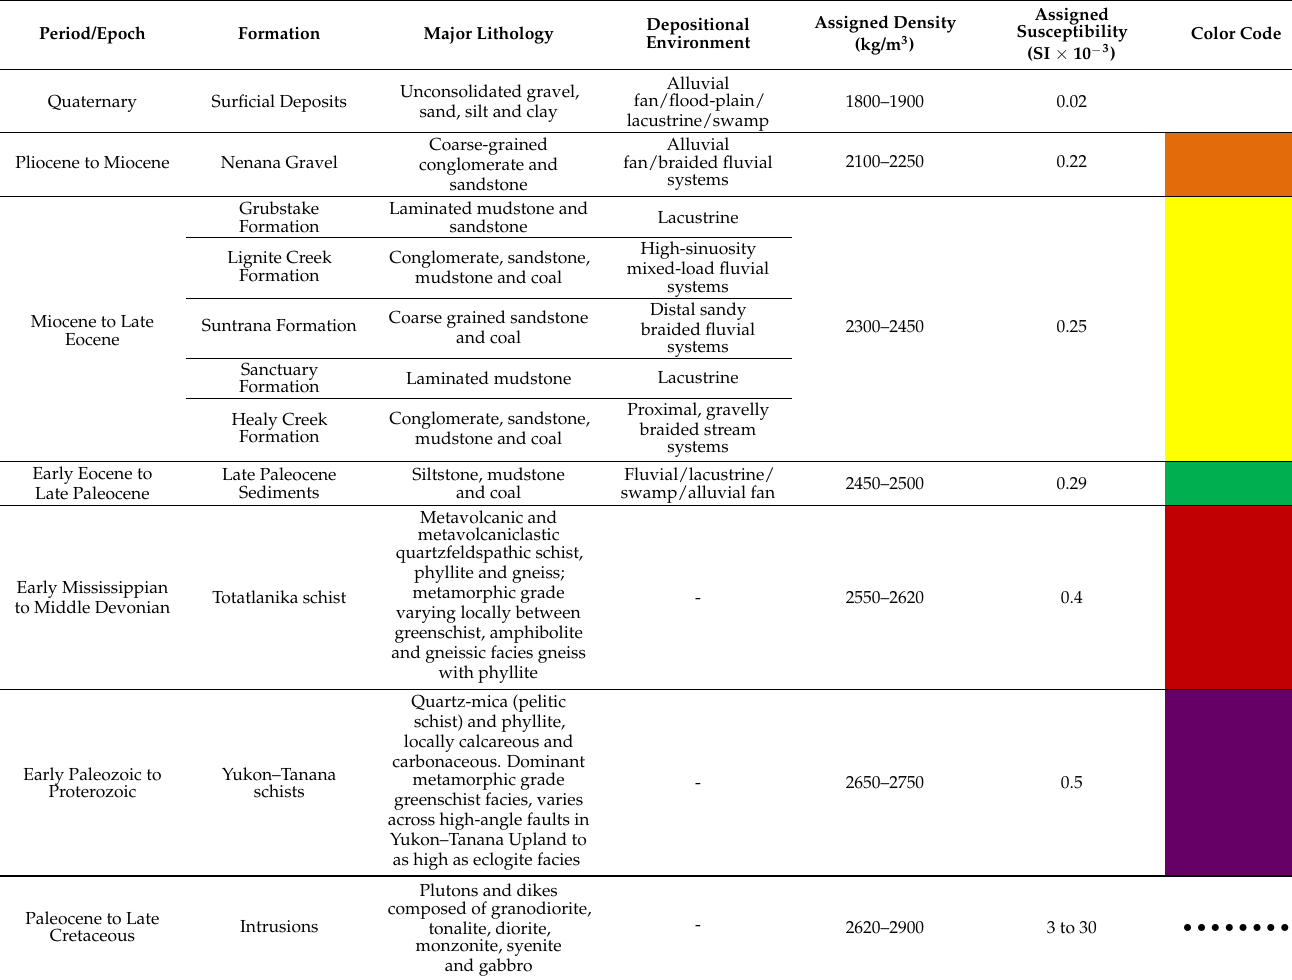
Table 1. Generalized stratigraphy and associated rock properties for units in the Nenana and Tanana basins and adjacent exposed rocks. Rock formations are color-coded and presented in geologic